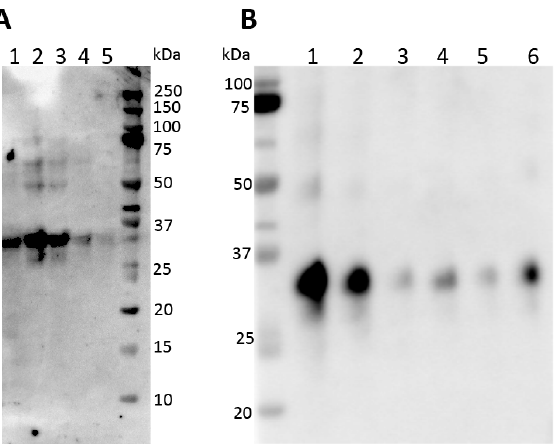
Figure 4. Inhibition of epithelial transport of osteopontin (OPN). Caco-2 cells were grown on transwell membranes and incubated with OPN in the apical compartment representing the intestinal luminal side. The cells were pre-incubated with inhibitor solutions or incubated at 4 ◦ C for 2 h before OPN was added, and then incubated for 2 h in the presence of inhibitors. OPN was detected in the basolateral medium by Western blotting using polyclonal anti-OPN antibodies. ( A ) Lane 1, cells incubated with OPN; lanes 2–5, cells incubated with OPN in the presence of inhibitors (lane 2, 10 mM Gly-Sar; lane 3, 0.5 µ g/mL Cytochalasin D; lanes 4–5, 1 µ M and 0.5 µ M wortmannin. ( B ) Lanes 1–2, cells incubated with OPN at 37 ◦ C; lanes 3–4; cells incubated with OPN at 37 ◦ C in the presence of 10 mM NaN 3 ; lanes 5–6, cells incubated with OPN at 4 ◦ C. The blots are representative of three ( A ) or two ( B ) individual experiments.